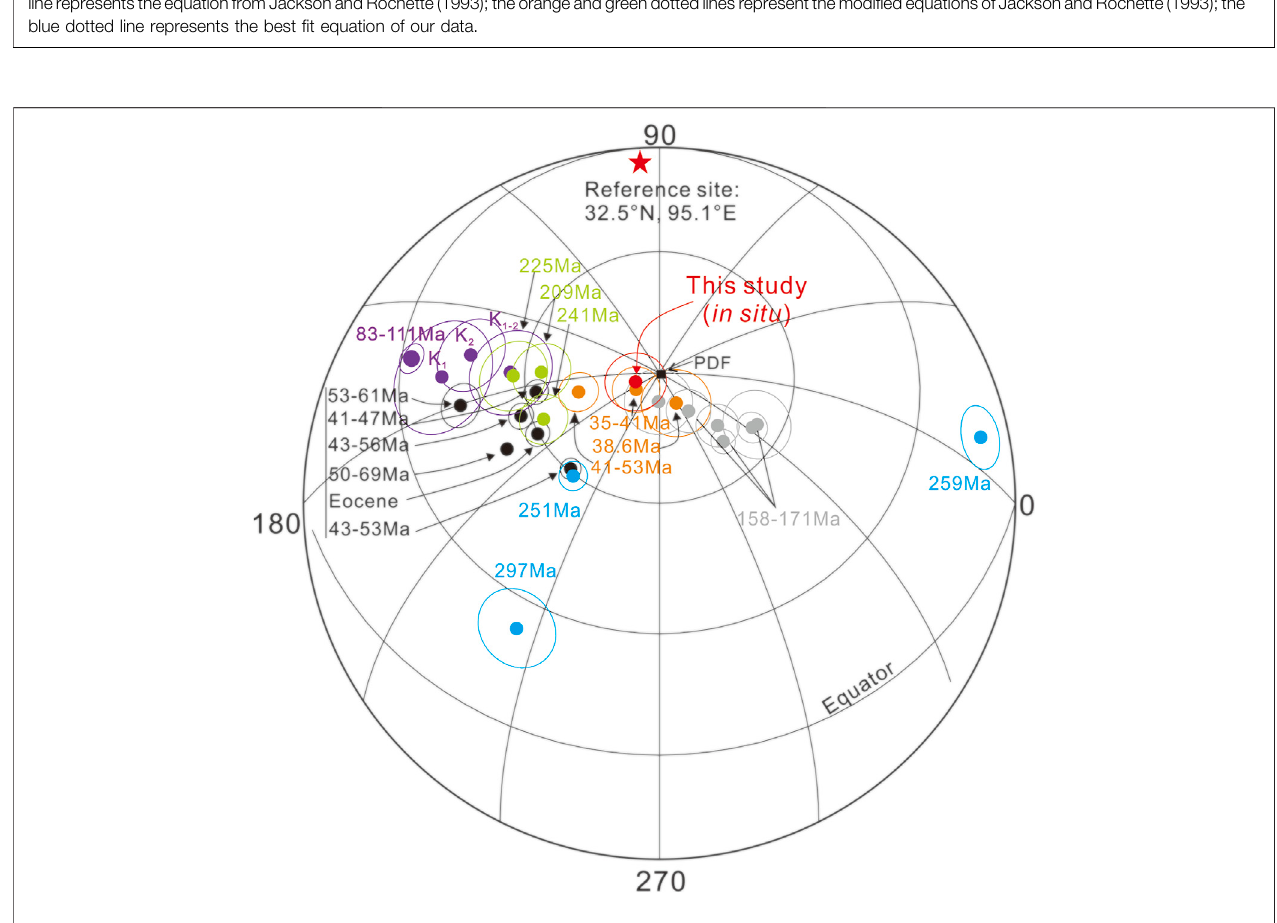
FIGURE 11 | Equal-area projection of the paleomagnetic poles of the EQT since the Late Paleozoic. Small-circle fi tting passing through paleopoles (colored circle) and centered on thereferencepoint (red star). Paleomagneticdata from Permian (1.Song et al., 2017;2. Ma et al., 2019;3. Guan et al., 2021),Triassic (4-5. Song et al., 2015,2020;6.Yuetal.,2022),Jurassic(7.Chengetal.,2012;8.Yanetal.,2016;9.Fuetal.,2021),Cretaceous(10.Huangetal.,1992;11.Tongetal.,2015;12.Meng et al., 2018), and Cenozoic (13. Lippert et al., 2011; 14. Tong et al., 2017; 15-16. Zhang et al., 2018, 2020; 17. Li et al., 2020; 18. Xiao et al., 2021). PDF represent the direction of the present-day geomagnetic fi eld.